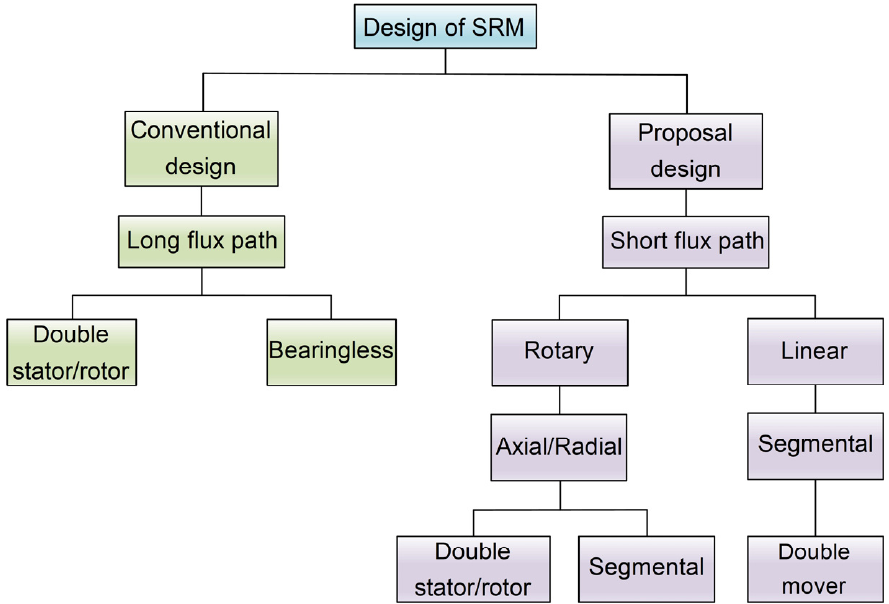
Figure 1. A classification of existing SRM topologies in recent years.